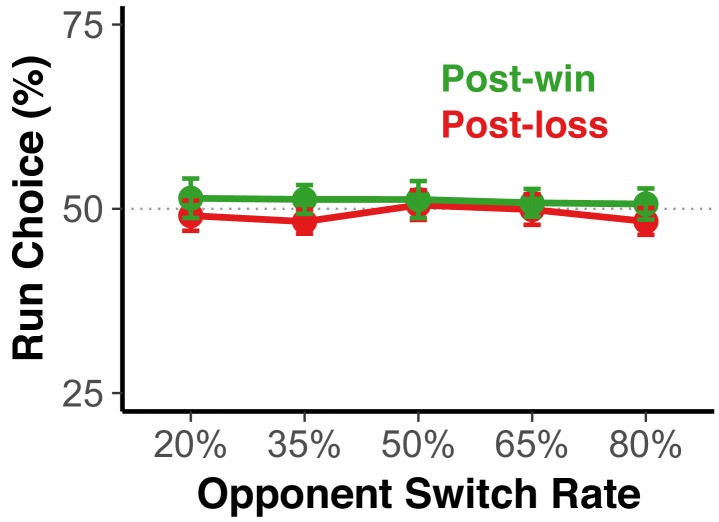
Analysis of action choices.Traditionally, when analyzing choice behavior in experimental games, the focus is on the how players choose between different options. Given that our behavioral signature for model-based and stochastic behavior was based on the rate of switching between action choices, we focused on the rate of switching between options as our primary dependent variable. To ensure that we are not missing important results by only focusing on switch rate, we also examined for all experiments the allocation of choices between the ‘freeze’ and the ‘run’ option (or ‘up’ and ‘down’ for Experiment 3), as well as the degree to which choices were affected by our key independent variables (post-win/post-loss and opponent switch rate). Across all experiments, the choices were fairly evenly distributed (i.e., close to 50% for either option). The independent variables had at best only very small effects that were not consistent across experiments. This figure supplement shows example results from Experiment 1; the pattern for the remaining experiments is very similar. Thus, there are no obvious results in the pattern of action choices that would qualify the conclusions form the switch-rate data.